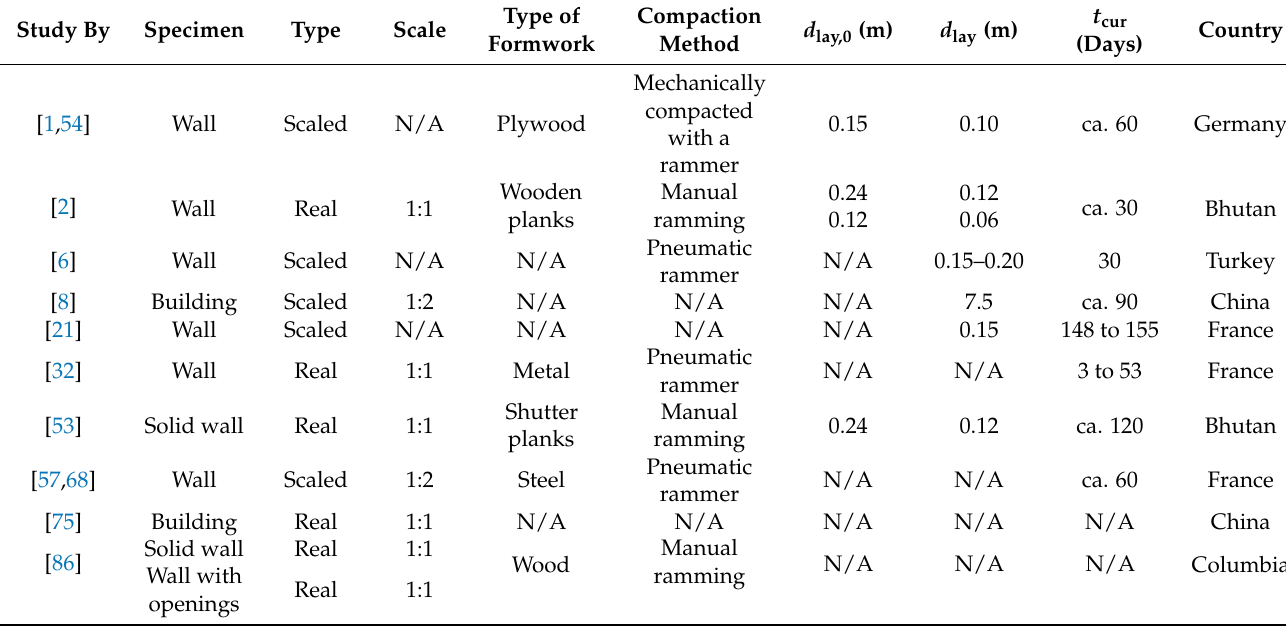
Table 9. Specimen geometry, preparation, and time of curing by country and study observed. Study